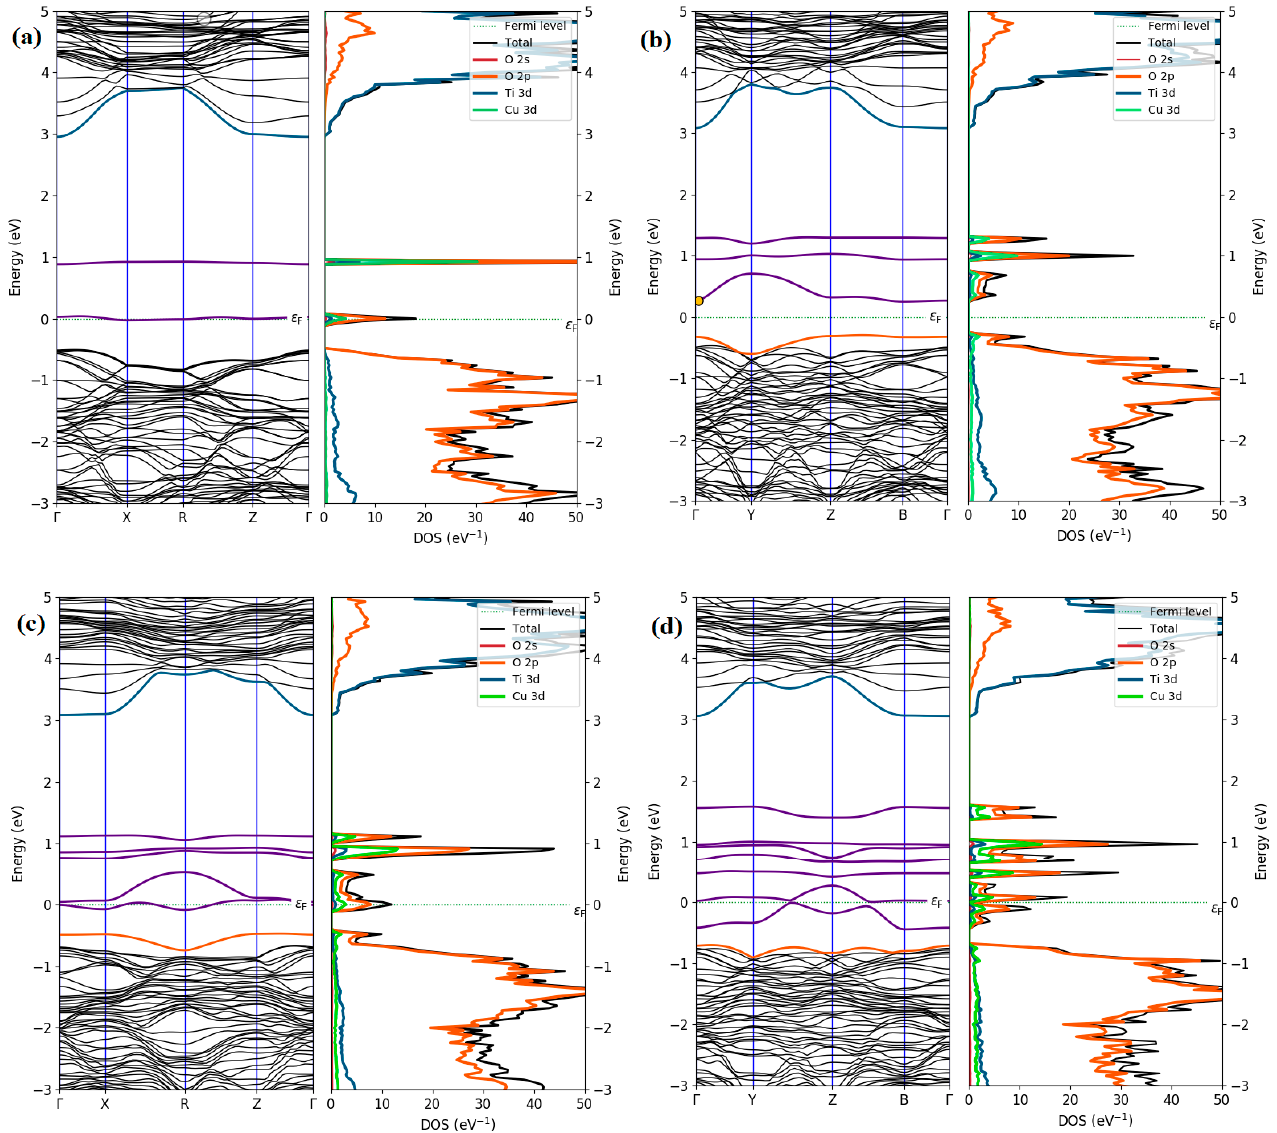
Figure 3. Calculated band structure and density of states of ( a ) 1Cu Ti , ( b ) 2Cu Ti , ( c ) 3Cu Ti , and ( d ) 4Cu Ti , doped TiO 2.